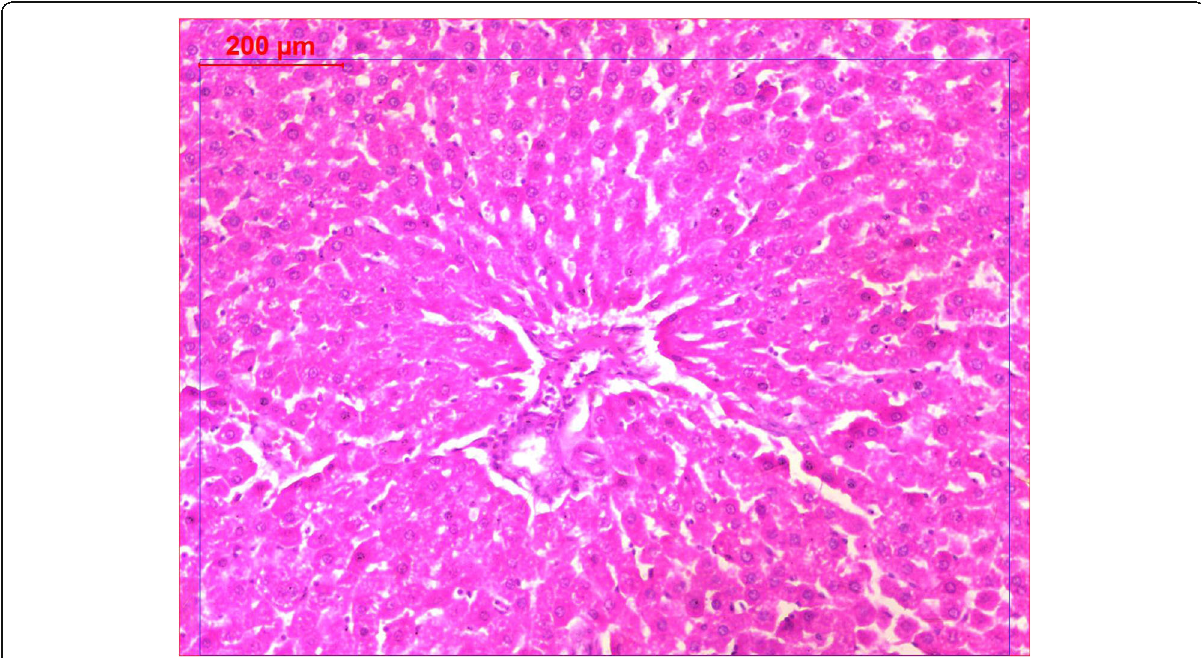
Fig. 4 Photomicrograph for the control group: normal liver tissue with preserved architecture and insignificant inflammation within normal limits (×